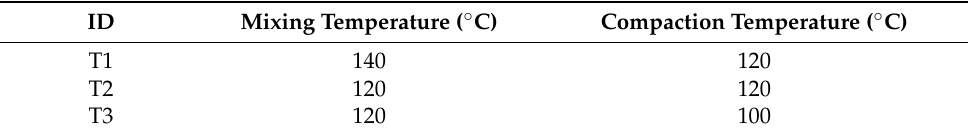
Table 2. Test temperatures for WMA